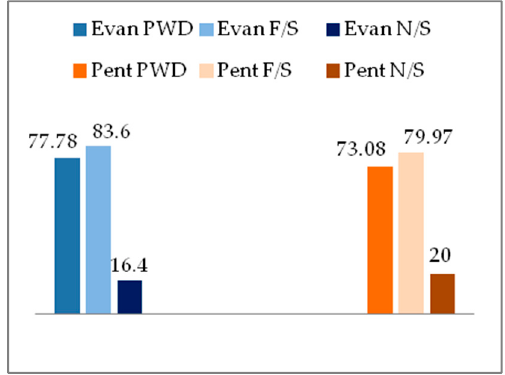
Figure 3. General Understanding Overall Average% Denominational Shifts.